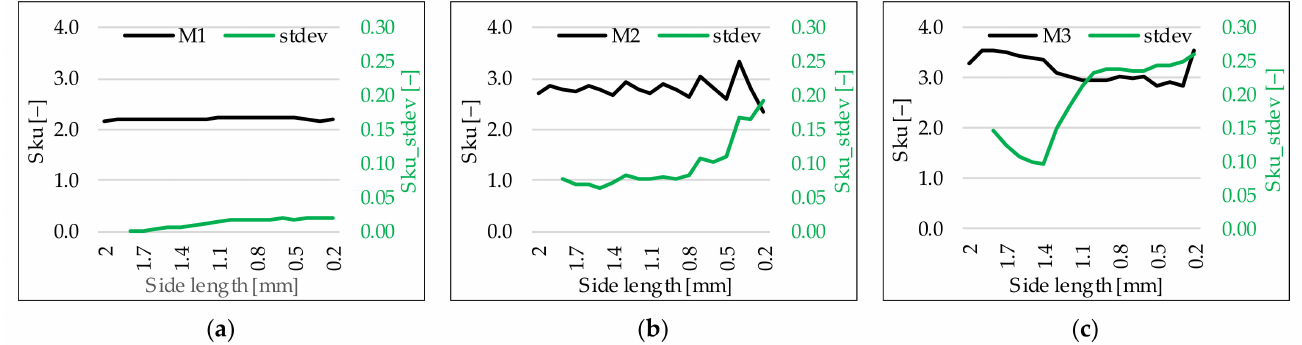
Figure 7. Sku parameters (black) and their standard deviations (green) as a function of the analyzed area (2 × 2 mm–0.2 × 0.2 mm): ( a ) M1—hard turning, f = 0.1 mm/rev; ( b ) M2—hard turning, f = 0.3 mm/rev; ( c ) M3—grinding.